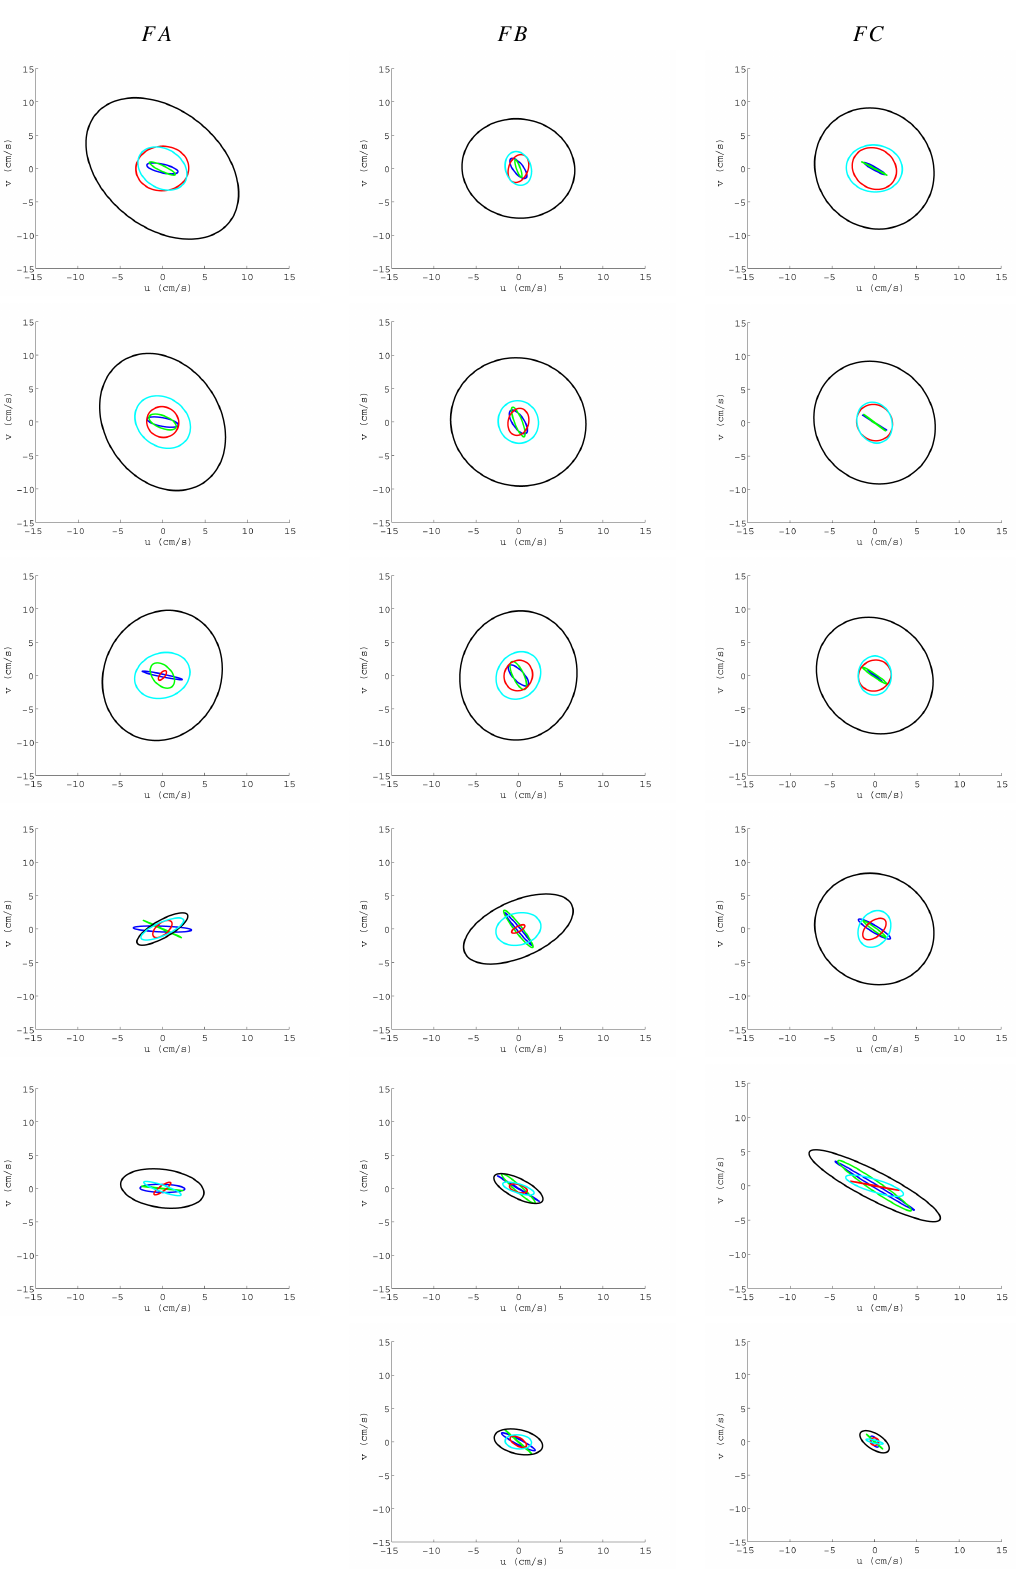
Fig. 7. Variation of tidal constituents ( M 2 black, S 2 cyan, N 2 red, O 1 blue and K 1 green) with depth (from top to bottom at about 220, 320, 420, 520, 620, and 720m depth) and space in the FBC